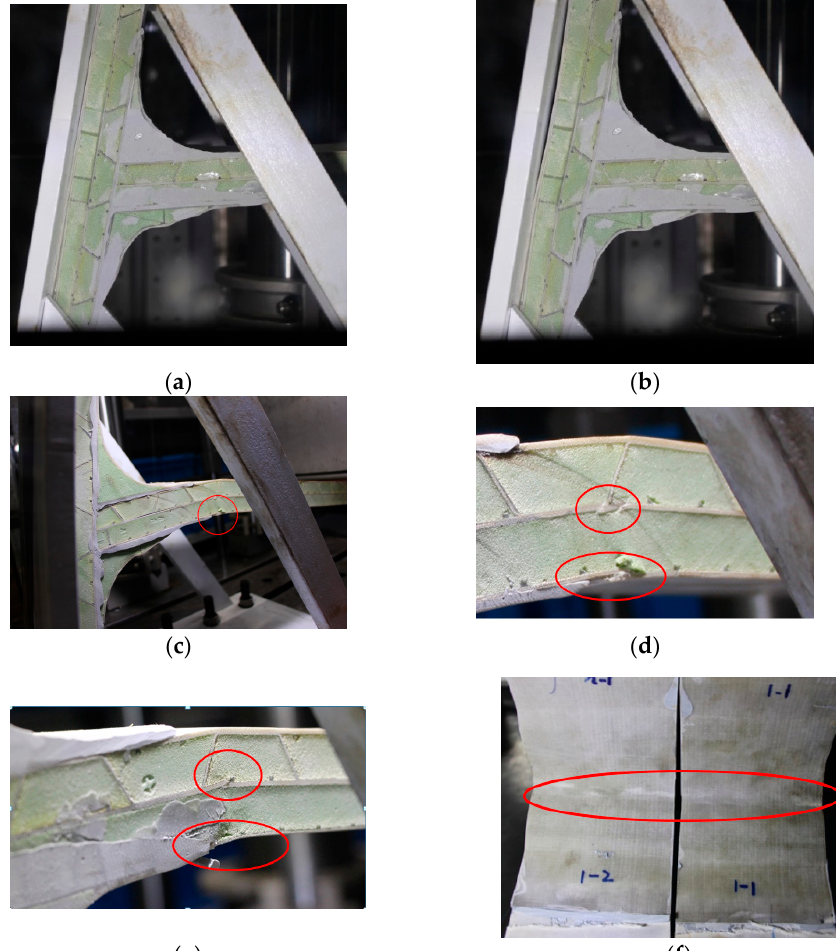
Figure 11. Deformation of the specimen during the loading process: ( a ) before the test; ( b ) linear elastic stage; ( c ) pseudo elastic stage; ( d ) detail of pseudo elastic stage; ( e ) failure stage; ( f ) damage stability expansion stage.